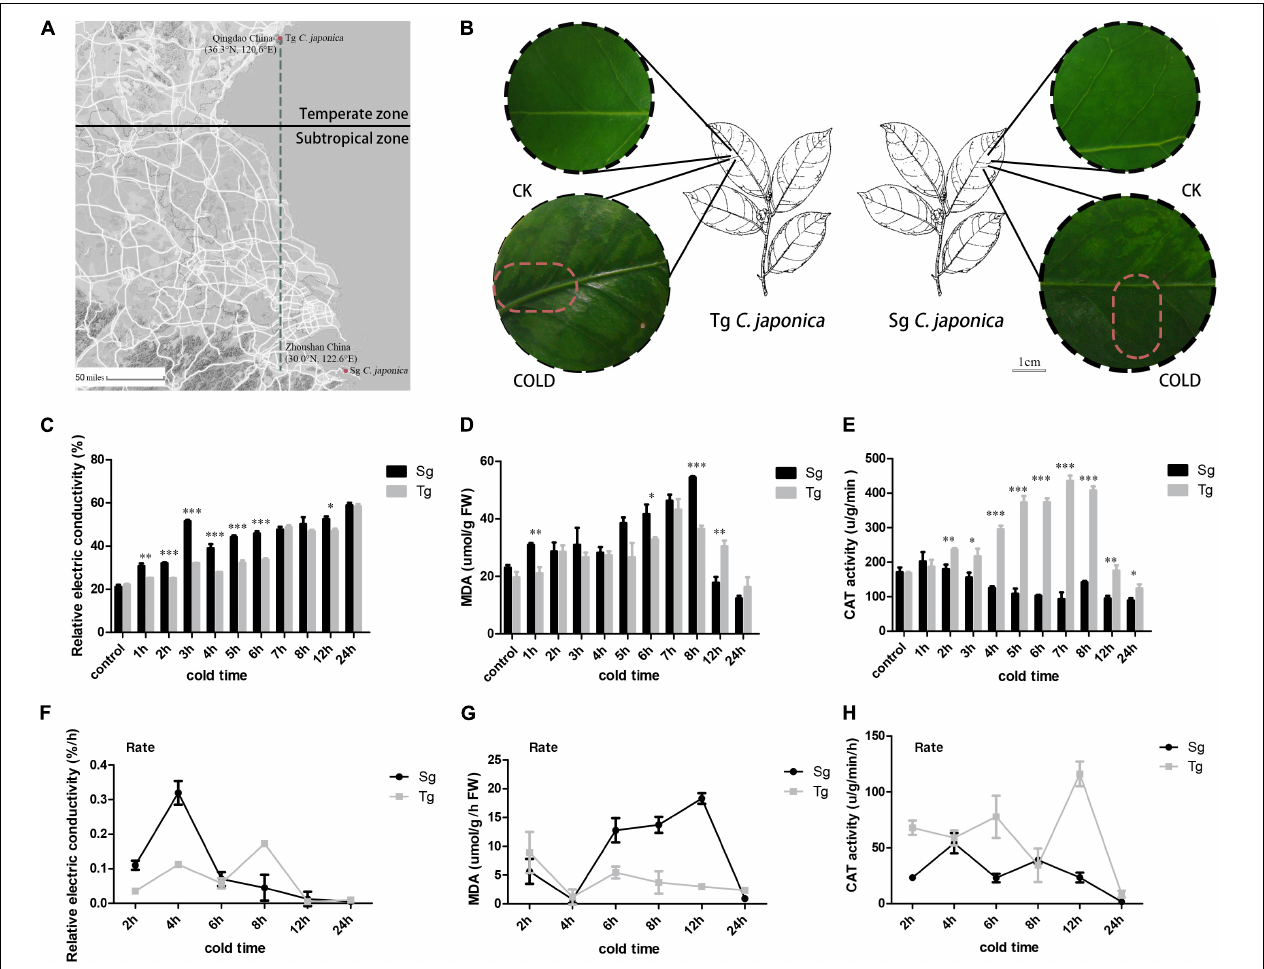
FIGURE 1 | Divergence of cold tolerance between temperate (Tg) and subtropical (Sg) C. japonica . (A) Distributions of the two C. japonica populations. The green line represents the latitudinal difference between the Sg and Tg populations. The raw map was downloaded from Google Maps (https://www.google.com/maps) (B) phenotypic changes in leaves under the 24 h cold treatment. The dark area represents the accumulation of cold damage. (C–E) Indicate the content of relative electric conductivity, MDA, and CAT activity, respectively. (F–H) Indicate changes in the rate of relative electric conductivity, MDA, and CAT activity, respectively. Data are mean ± SD of three independent experiments, ∗ indicates a significant difference at P < 0.05 between Tg and Sg C. japonica at a particular time by Student’s t -test. ∗∗ p < 0.01, ∗∗∗ p <